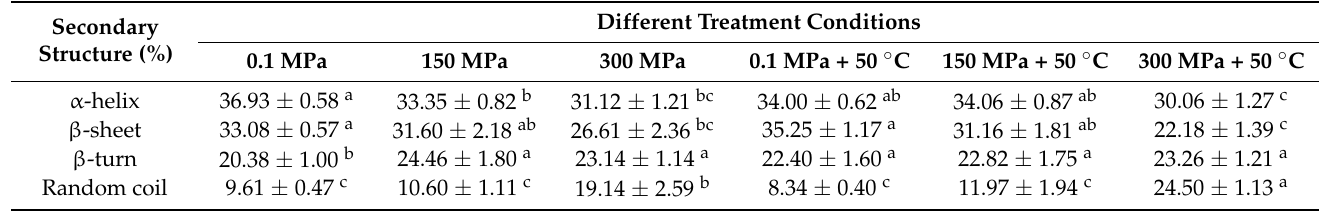
Table 1. The effect of different treatment conditions (0.1 MPa, 150 MPa, 300 MPa, 0.1 MPa + 50 ◦ C,